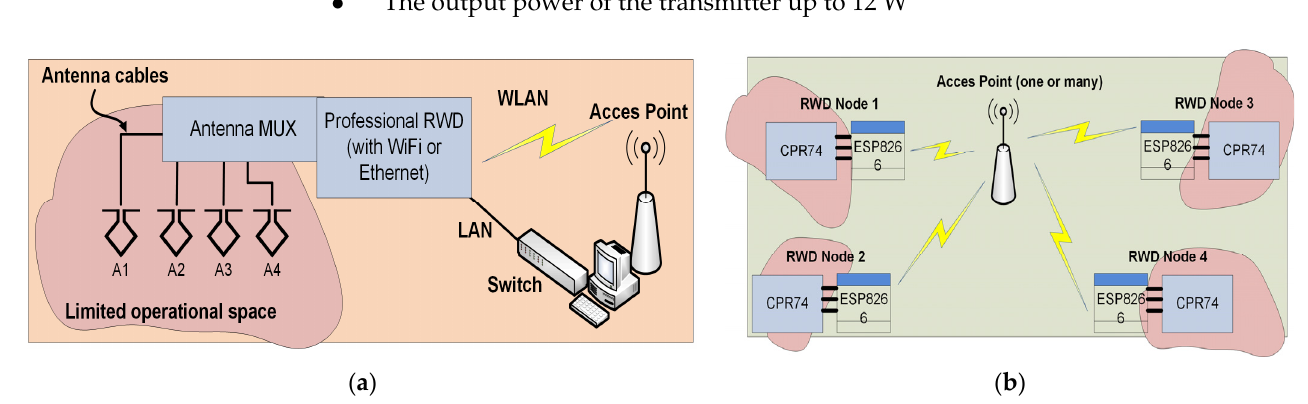
Figure 8. RFID system: ( a ) Standard arrangement; ( b ) Distributed platform.